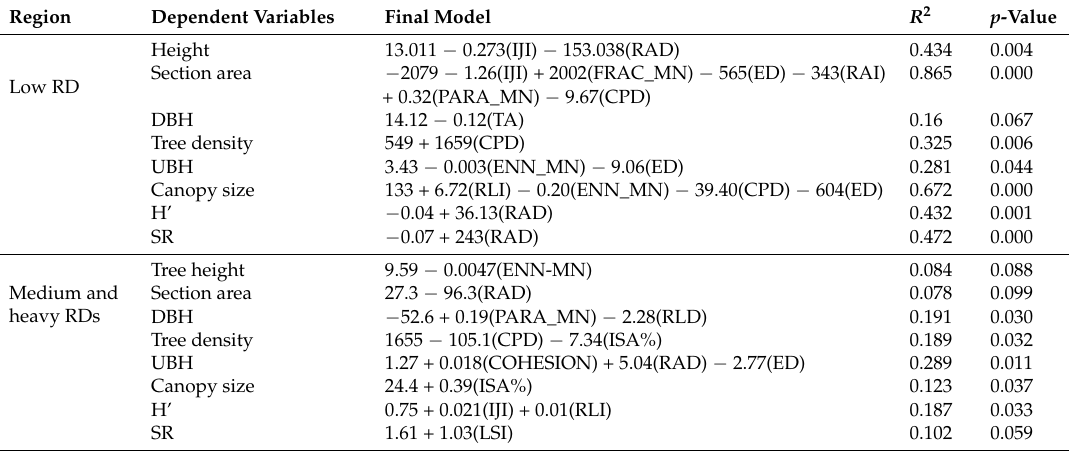
Table 4. Stepwise regressions between forest attributes and road characteristics (structural attributes and taxonomic attributes) and landscape metrics in the different road density (RD) regions. The selected variables were selected at a probability of less than 0.05 for the F value. The coefficients of determination ( R 2 ) and p -value ( p ) are also given for each model, and the data are listed in this